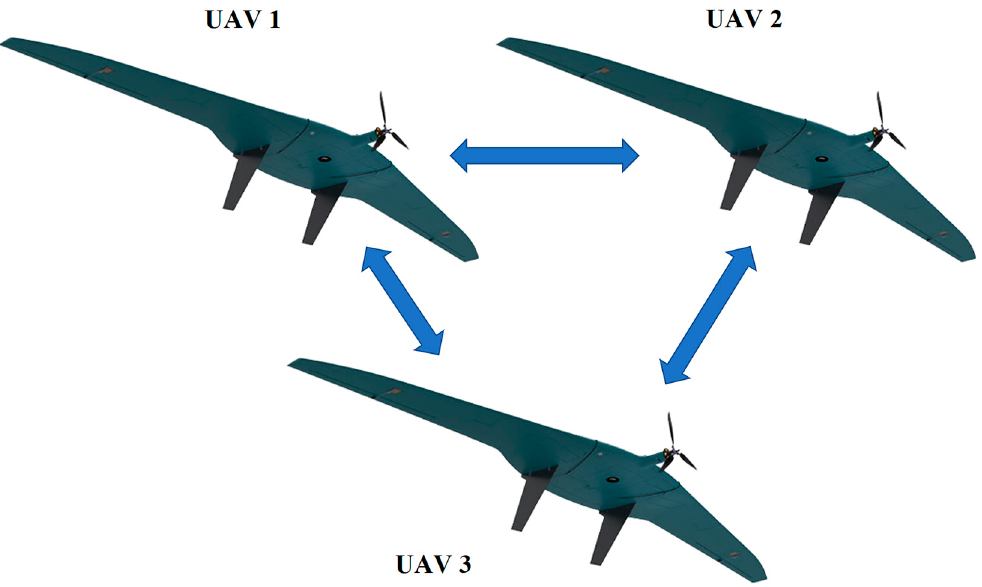
Figure 2. Scheme of the communication option “UAV—UAV”.